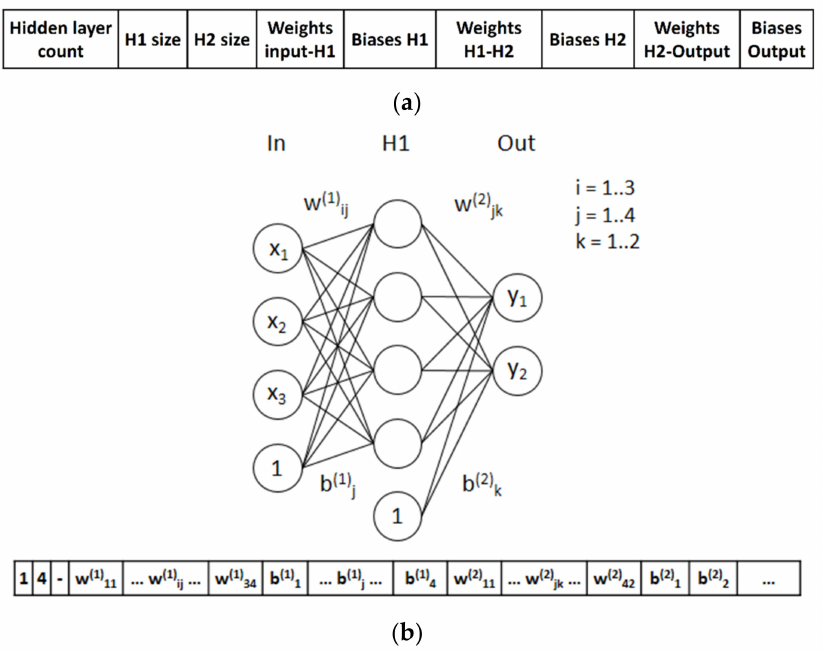
Figure 1. Arranging (flattening) the parameters of a neural network into a 1D array forming a chromosome. The flattening method is illustrated for neural networks with a maximum of two hidden layers but is easily adaptable to larger architectures. ( a ) The general format, regardless of the actual neural network architecture; ( b ) An example of flattening a single hidden layer network into a